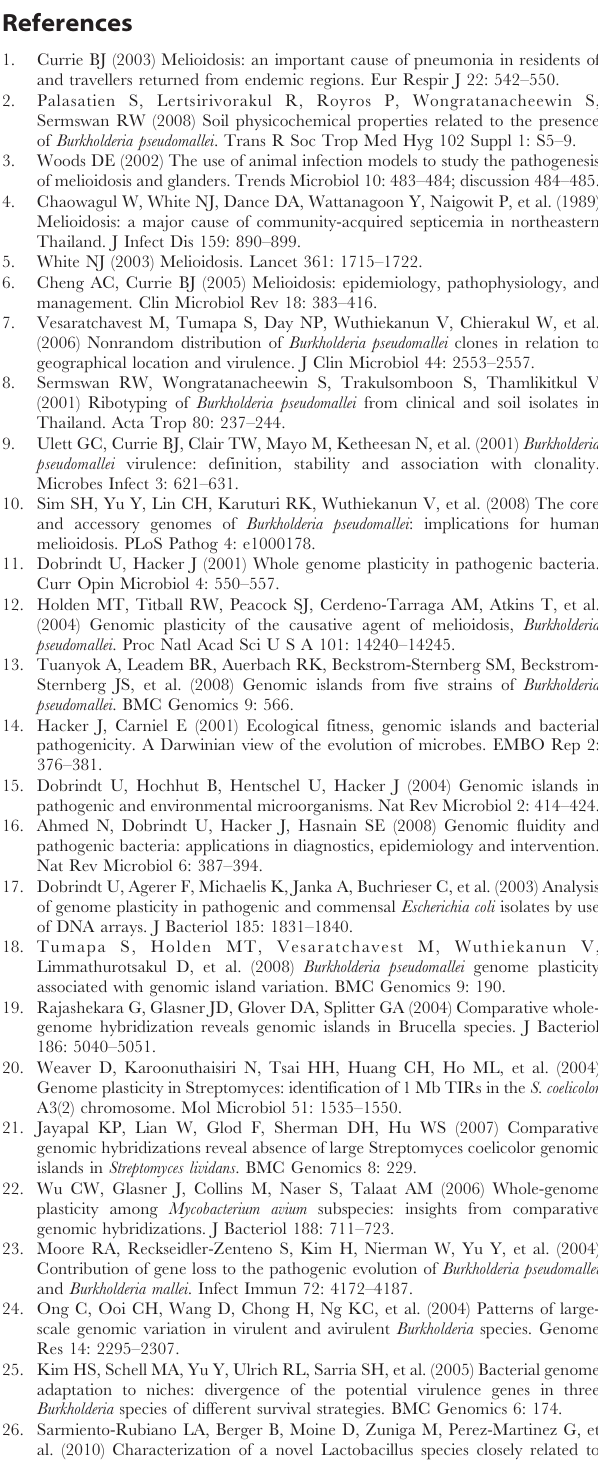
Table S4 Primer sequences used for GIs confirmation and specific genes